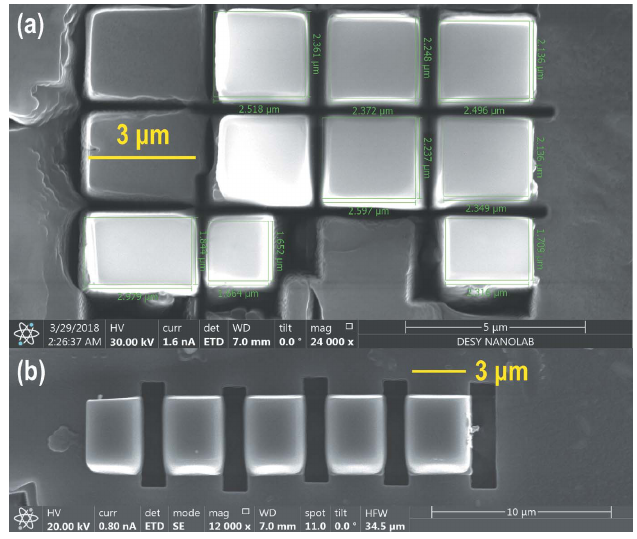
Figure 6 SEM images produced by the SCIOS dual-beam FIB at the